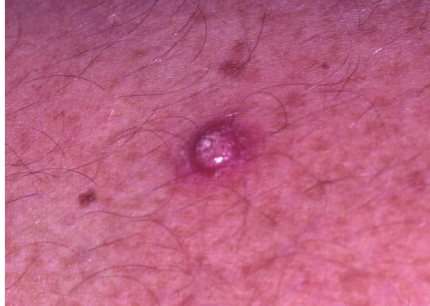
Figure 14: Keratoacanthoma: clinical photograph showing a well- circumscribed reddish nodule with erosion on the surface.